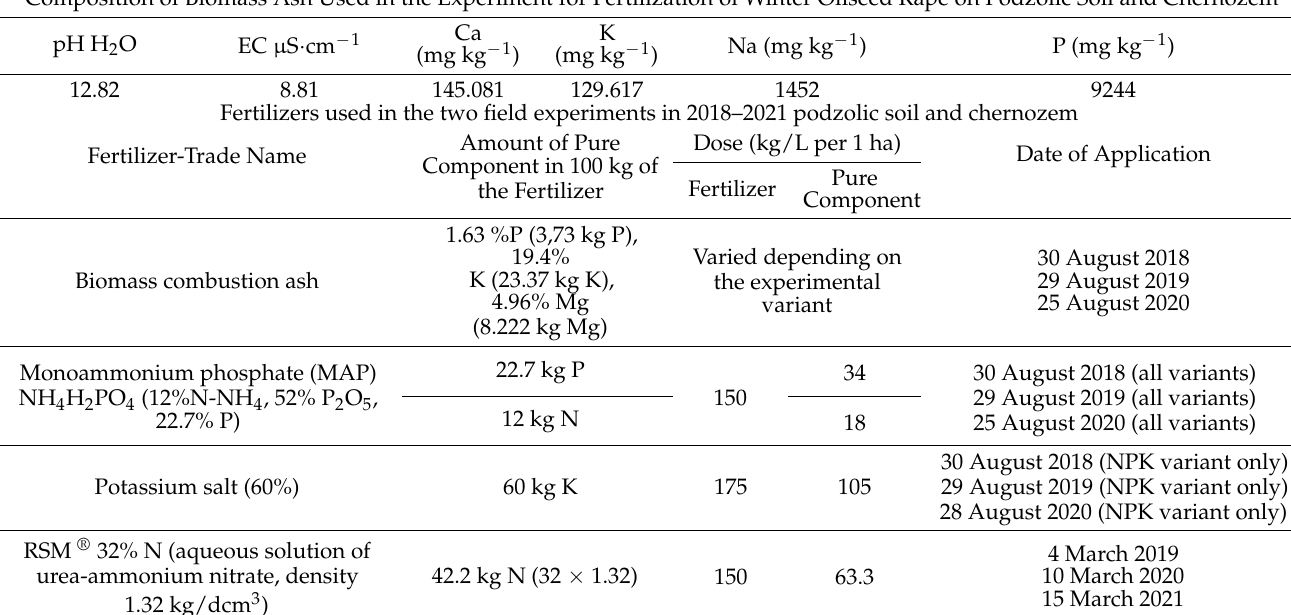
Table 1. Overview of the characteristics of ash from biomass combustion and applied fertilizer doses. Composition of Biomass Ash Used in the Experiment for Fertilization of Winter Oilseed Rape on Podzolic Soil and